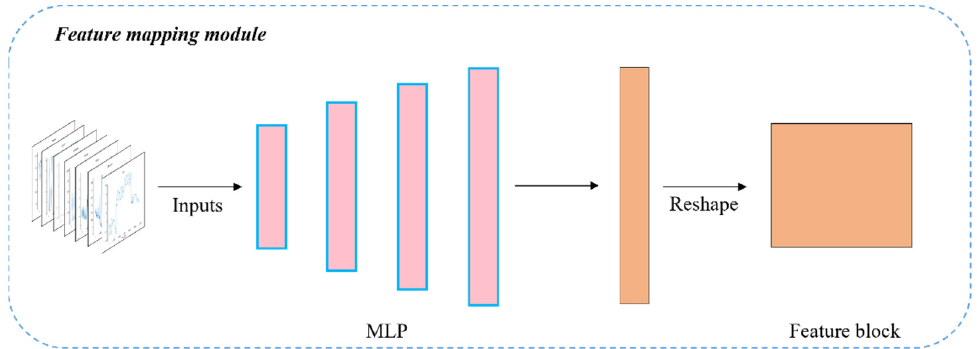
Figure 4. Schematic of environmental data features mapping module.